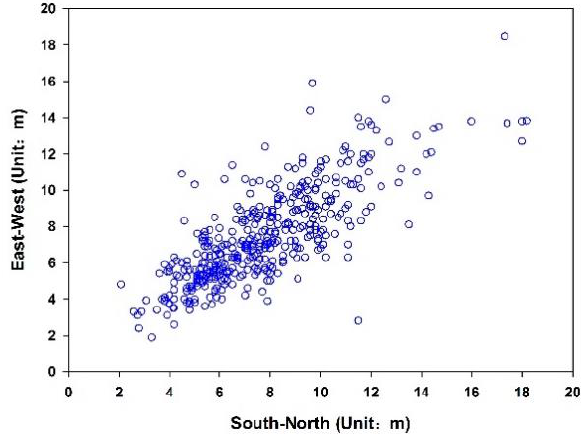
Figure 4. Scatter diagram for Ulmus pumila crown diameters measured during field surveys of the study area.